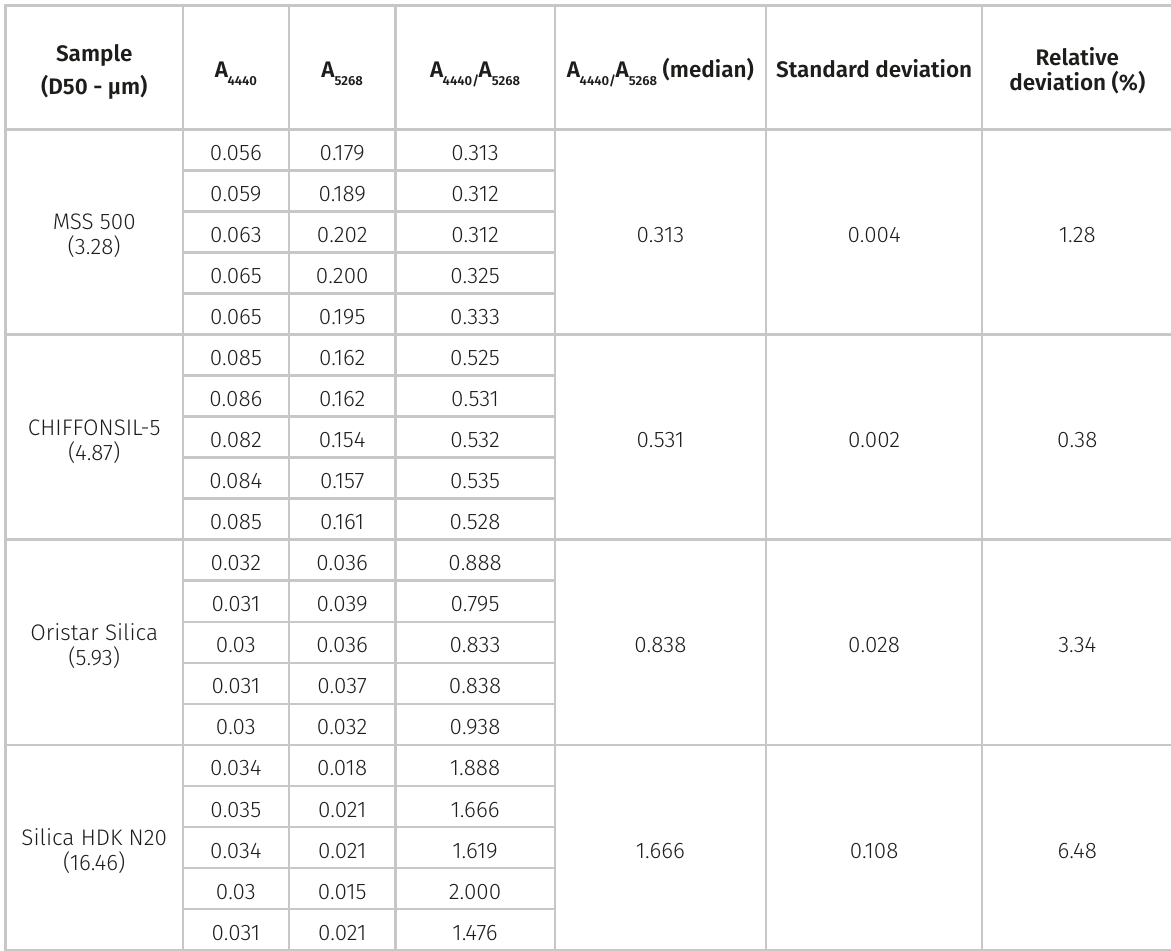
A ) for silica samples, with D50 data measured by Fraunhofer 5268